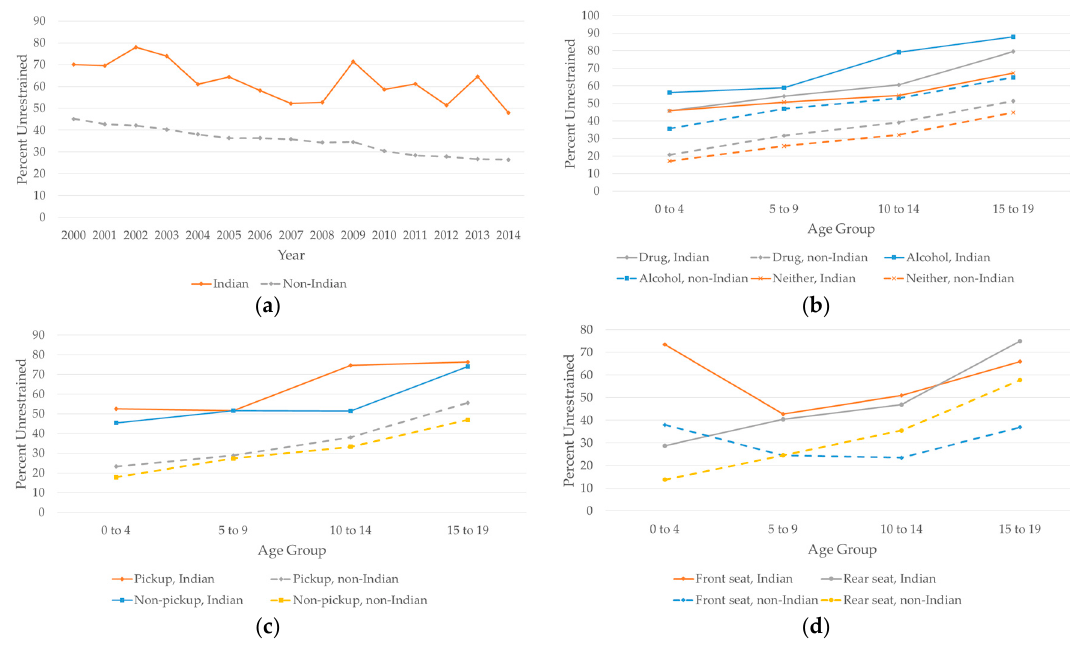
Figure 2. Percentage of unrestrained passengers aged 0–19 years old by different factors on Indian lands compared to non-Indian lands: ( a ) Percentage of unrestrained passengers by year; ( b ) Percentage of unrestrained passengers for driver drug and alcohol use; ( c ) Percentage of unrestrained passengers for pickup trucks and non-pickup trucks; and ( d ) Percentage of unrestrained passengers for front seat and rear seat.